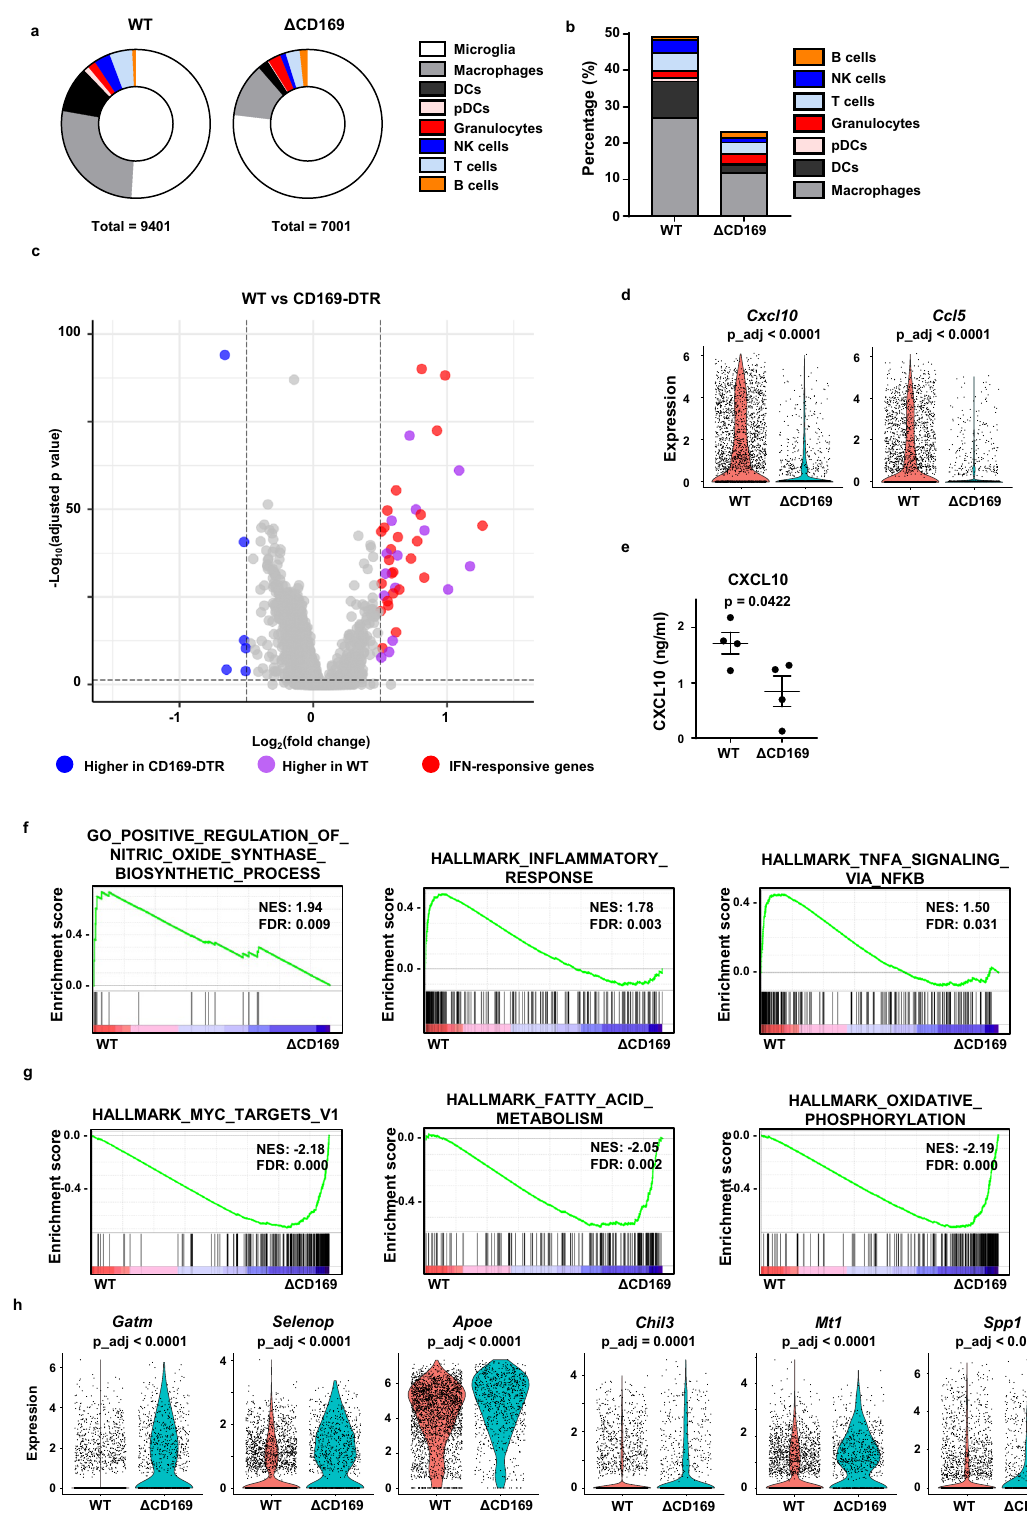
Fig. 3 | CD169 + macrophages are IFN-responsive in fl ammatory macrophages. Wild-type ( n =3) and CD169-DTR ( n =3) mice were intracranially injected with GL261. Mice were intraperitoneally injected with DT at − 1 and +4 days of tumor injection. Ten days post-inoculation (dpi) of GL261, single cells were isolated and pooled. CD45.2 + immune cells were sorted and analyzed by scRNAseq. a , b Percentage of each immune cell cluster in gliomas of WT and CD169 + cell- depleted mice. c A DEG plot shows macrophage clusters of WT and CD169-DTR mice (gray dots indicate |log 2 (fold change)| <0.5 or adjusted p -value >0.05). d Geneexpressionofproin fl ammatorychemokines( Cxcl10 and Ccl5 ). e Expression